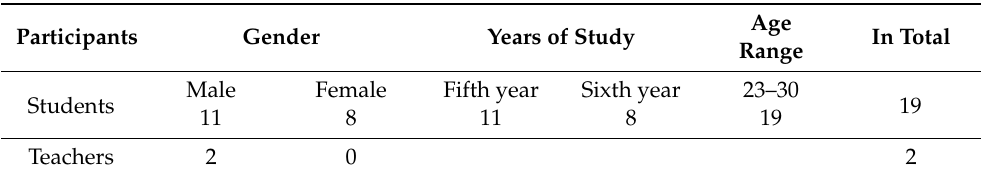
Table 1. Background information on the